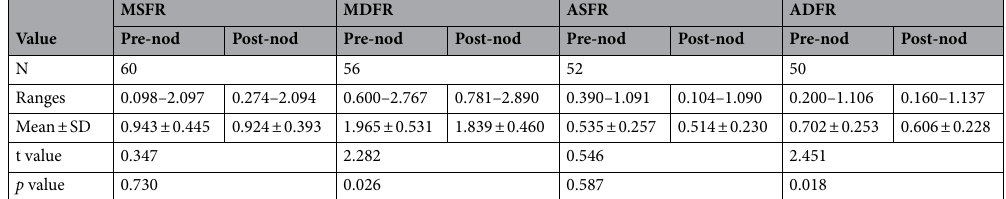
Table 3. Comparison of the amplitude parameters obtained before and after the head-nodding period. Amplitude values were given in milliliters per second. The outliers were removed on the base of Box and Whisker Plots analysis.